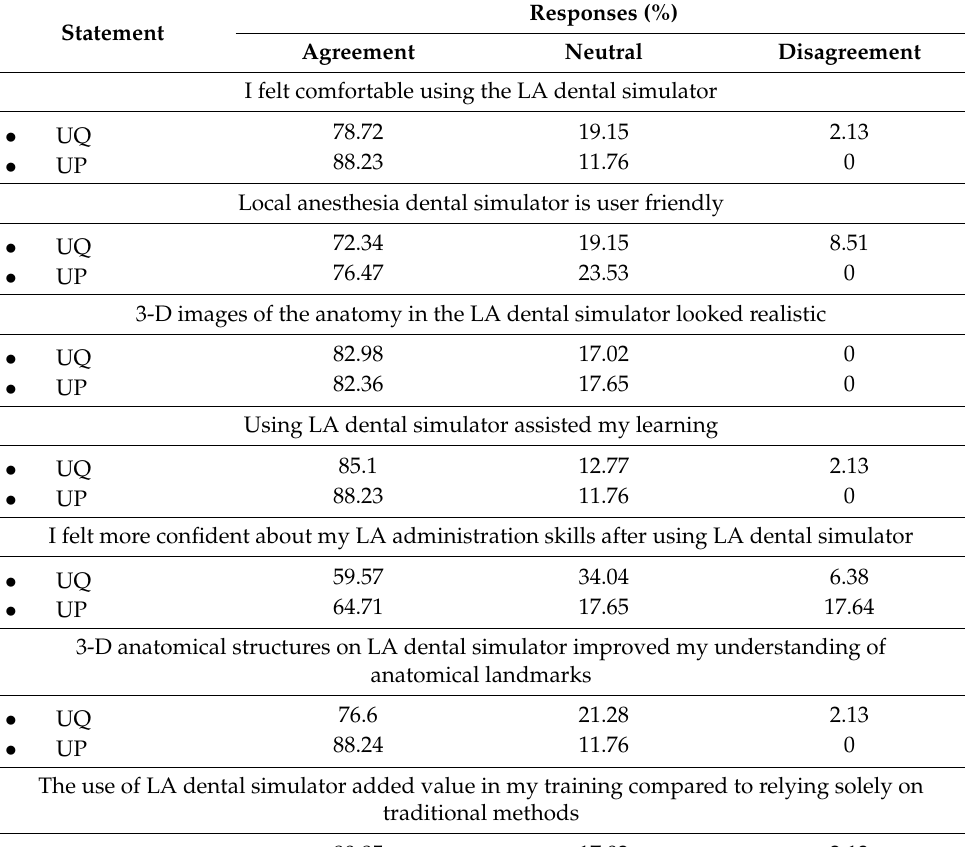
Table 2. Post-training perceptions of dental